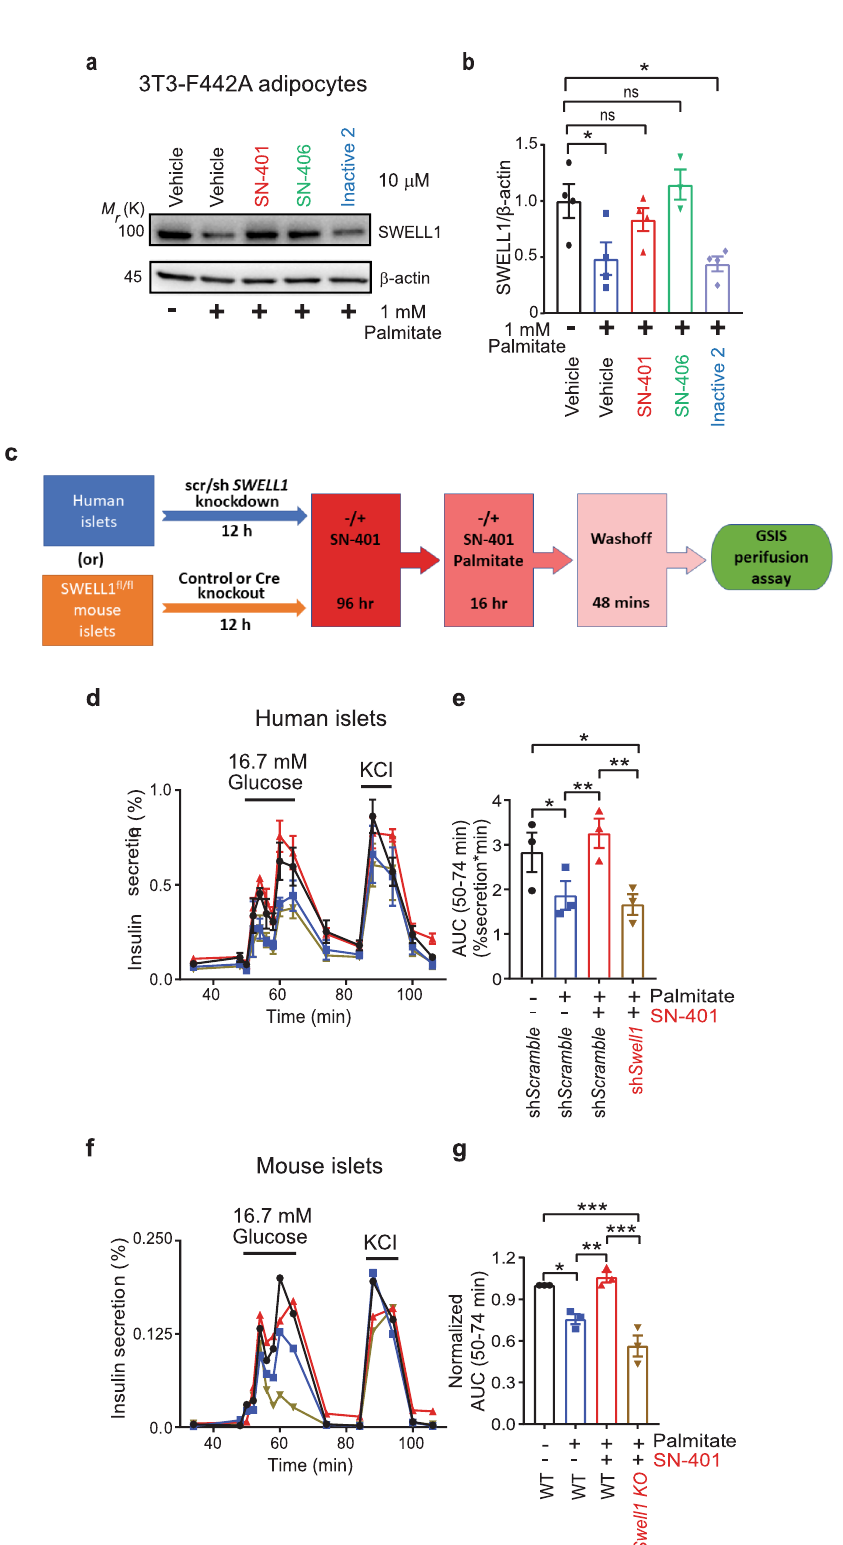
prior to collecting lysates. In the case of 3T3-F442A adipocytes, the WT and KO cells were treated with either vehicle (DMSO), 1 or 10µM SN-40X (after 7 – 11 days of differentiation) for 96h and then stimulated with 0 and 10nM insulin/serum- containing media with vehicle (DMSO) or SN-40X for 15min for SWELL1